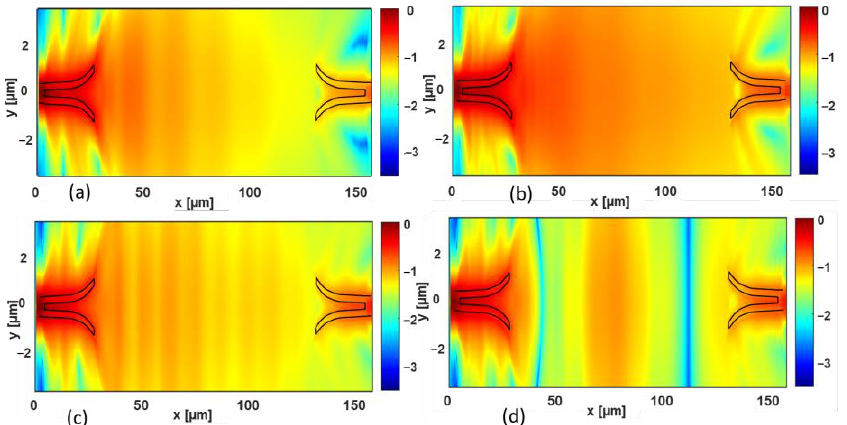
Figure 12. Normalized electric field (in logarithmic scale) calculated in the xy-vertical plane for z = 0 µ m (i.e., in the middle of the antennas) for the TE polarization. The link distance is d link = 100 µ m, and different values of the thickness d are considered, namely: ( a ) d = 0.5 µ m, ( b ) d = 0.9 µ m, ( c ) d = 3 µ m, and ( d ) d = 4 µ m. The antennas are denoted by the black lines. The wavelength is λ = 1.55 µ m.